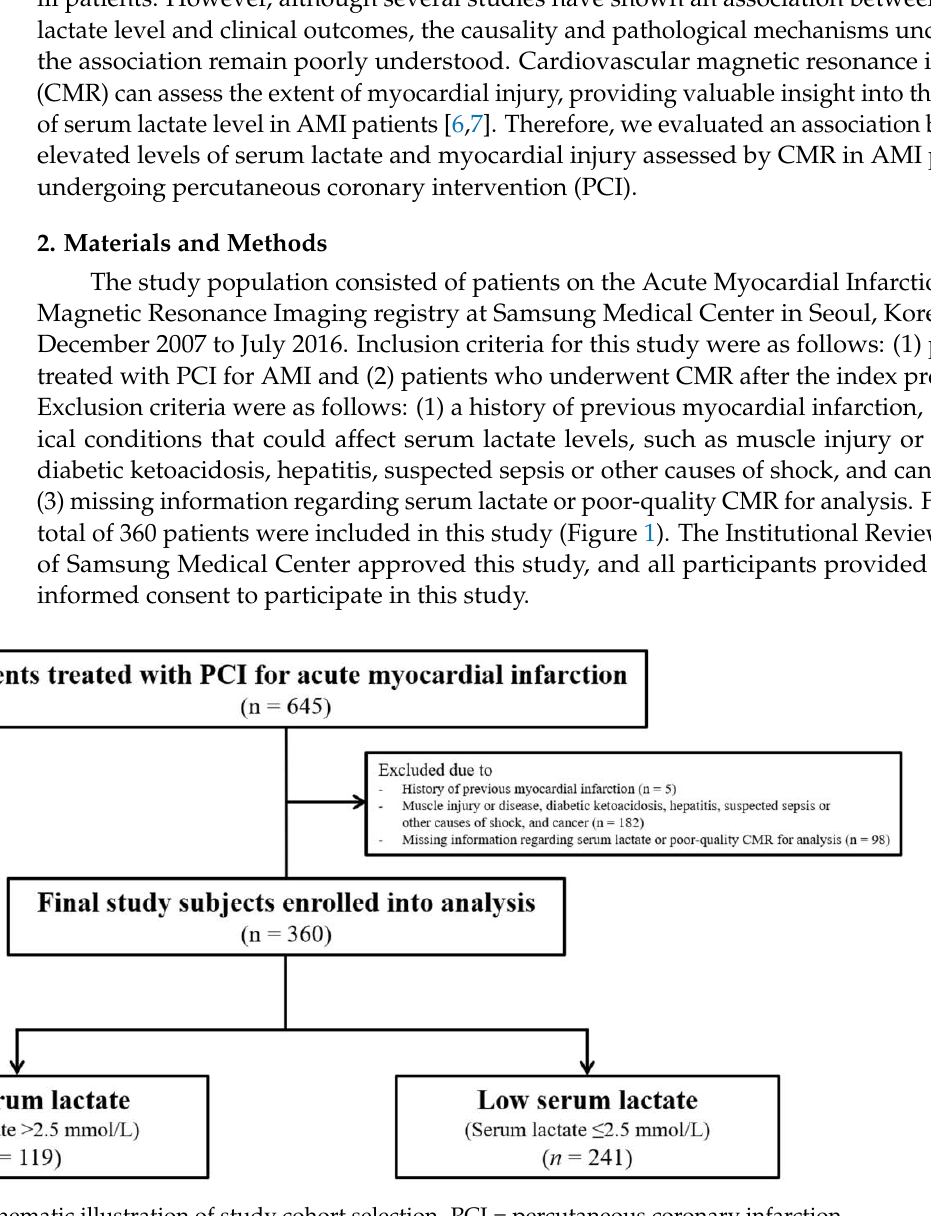
Figure 1. Schematic illustration of study cohort selection. PCI = percutaneous coronary infarction. Serum lactate level was measured from the study patients upon admission before any therapy. Since there is no known definitive lactate level to predict myocardial injury, and previous studies have suggested various baseline lactate levels, from 1.8 to 6.5 mmol/L as independent prognostic factors [3,8,9], we obtained the best threshold value of serum lactate (2.5 mmol/L) to predict large myocardial infarct. Based on this value, study patients were divided into two groups: those with serum lactate levels > 2.5 mmol/L (high serum lactate group) and those with serum lactate levels ≤ 2.5 mmol/L (low serum lactate group). We additionally stratified the study population into three subgroups according to lactate levels of 2.5 mmol/L and 4.0 mmol/L, to clarify the correlation between serum lactate and myocardial infarct size: a lactate ≤ 2.5 mmol/L group, a lactate > 2.5–4.0 mmol/L group, and a lactate > 4.0 mmol/L group